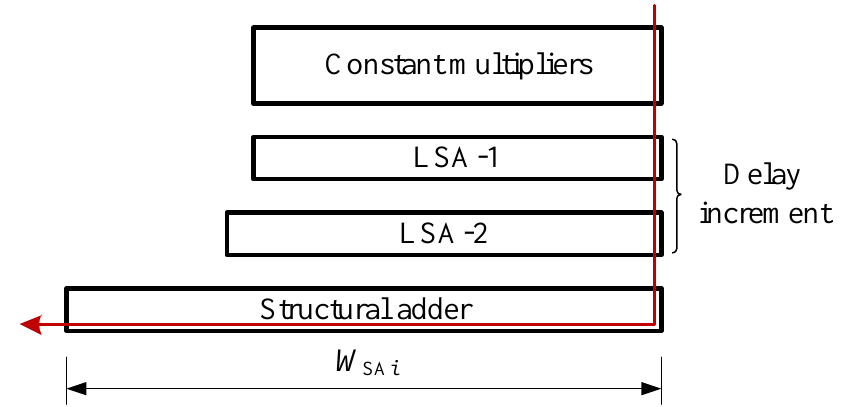
Figure 6. Computation of a group with two-stage LSAs.